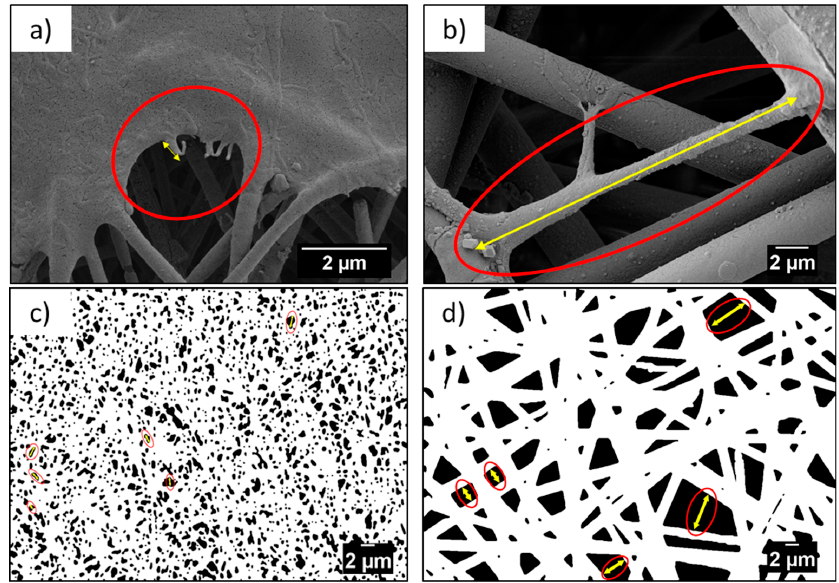
Figure 1. Example of measurement ( a , b ) cells’ filopodia, L c , and ( c , d ) distance measurement between fibers, S f , from the SEM micrographs between nanofibers and microfibers, respectively.